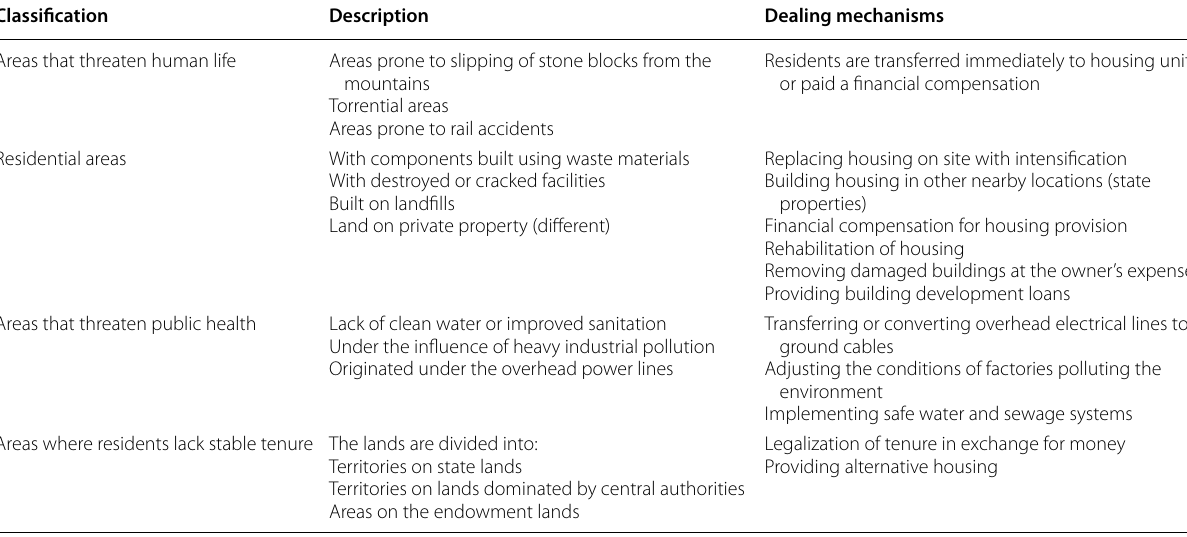
Source: Presidency of the Council of Ministers Slums Development